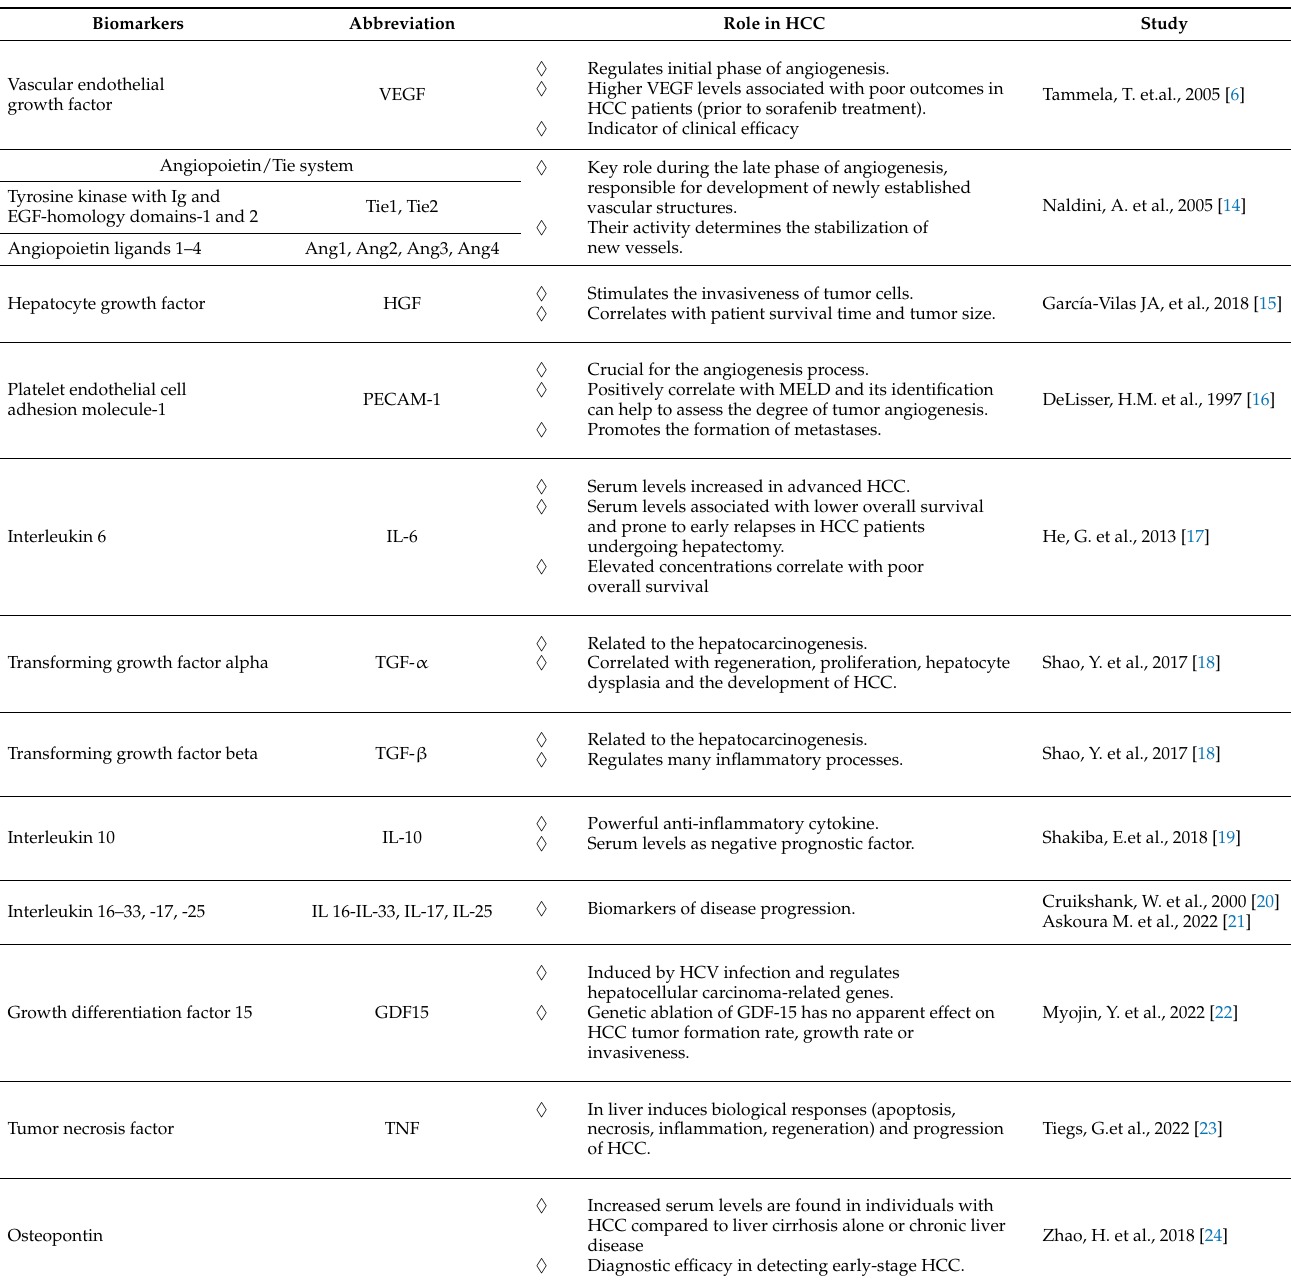
Table 1. Role of the main cytokines and growth factors in